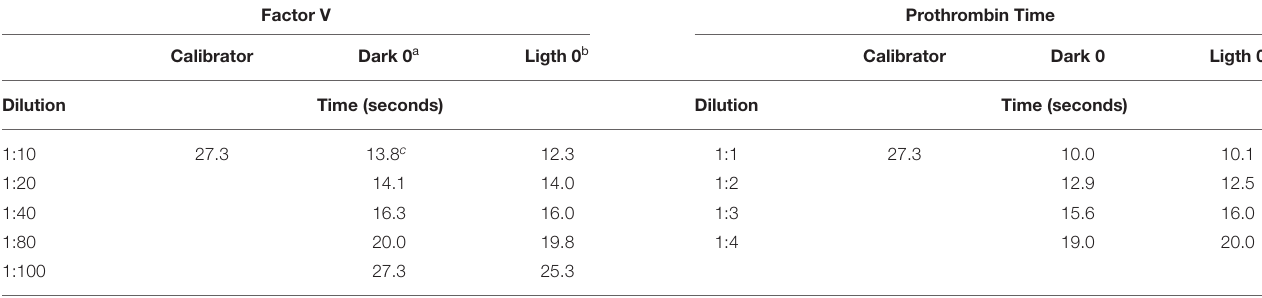
a Onset of dark. b Onset of